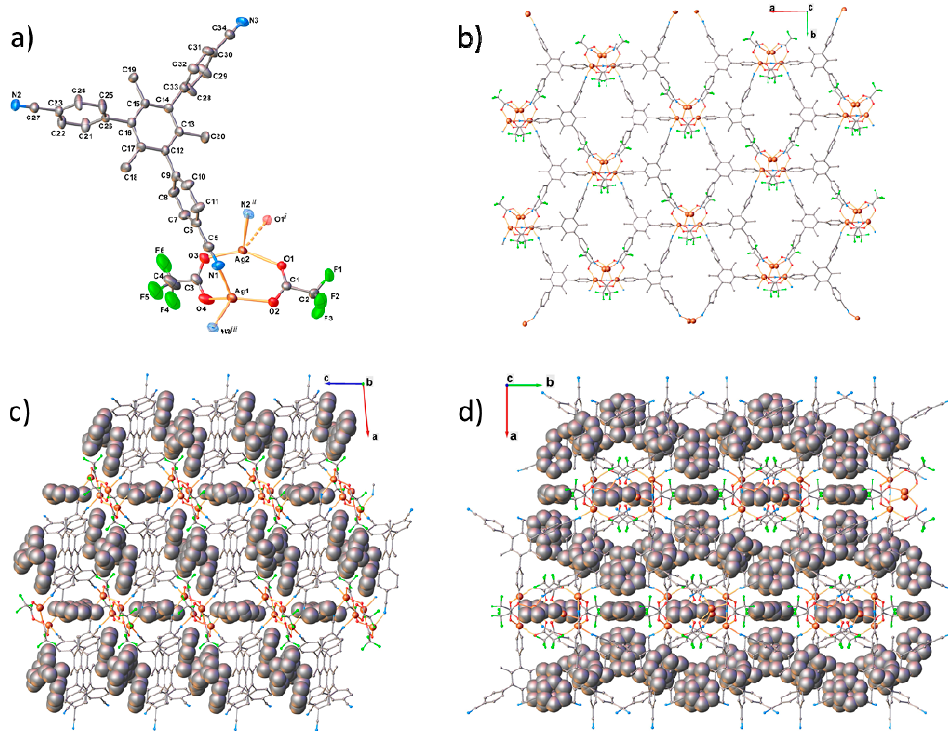
Figure 4. a ) The asymmetric unit in the crystal structure of {[Ag 2 L(Tf) 2 ] ∙ 3C 7 H 8 } n ( 12 ) with atom labelling and thermal ellipsoids at 40% level; b ) View of 2D coordination network; c ) Partial view of the crystal structure along b axis with space filling of guest toluene molecules; d ) Partial view of the crystal structure along c axis. H ‐ atoms are not shown. Symmetry codes: i ) 1 ‐ x , 1 ‐ y , 1 ‐ z ; ii ) 0.5 ‐ x , y ‐ 0.5, 0.5 ‐ z ; iii ) 0.5 + x , 0.5 + y , z ..